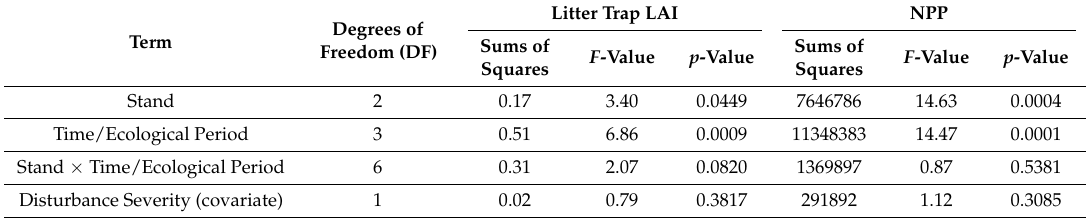
Table A1. Full factorial two-way analysis of variance (ANOVA) results testing for the effects stand, ecological period (seen in Figure 2), and the stand × ecological period had on both LAI (dimensionless) and net primary production (NPP) (Mg C ha − 1 year -1 ). Significant differences are in